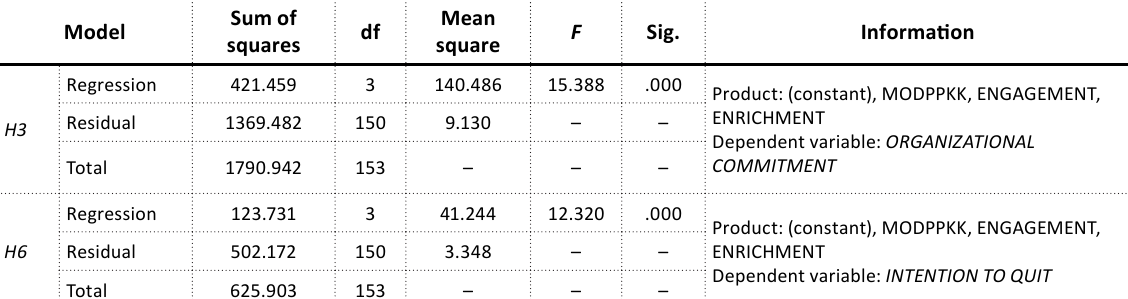
Table 3. F -test result